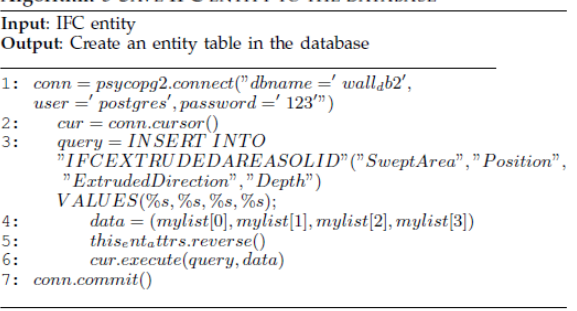
Figure 11: Save IFC entity to the database 4.4 IFC data access in PostgreSQL Data from the IFC file (3D_wall.ifc) is stored into the PostgreSQL database, in tables of the corresponding entities as shown in Figure 12. With the SQL SELECT (Select * from "IFCEXTRUDEDAREASOLID";) statement the 3D view of the object is presented in the FreeCAD, using the appropriate API (FreeCADGui API or Base API). The FreeCADGui API contains everything related to the user interface and the 3D views while the Base API contains constructors for different types of objects heavily used in FreeCAD. Also, an appropriate interface (GUI) for the software is under development, which will present the IFC data like a table-view form. The stage of the script development is Pre-Alpha (Python script before formal testing).